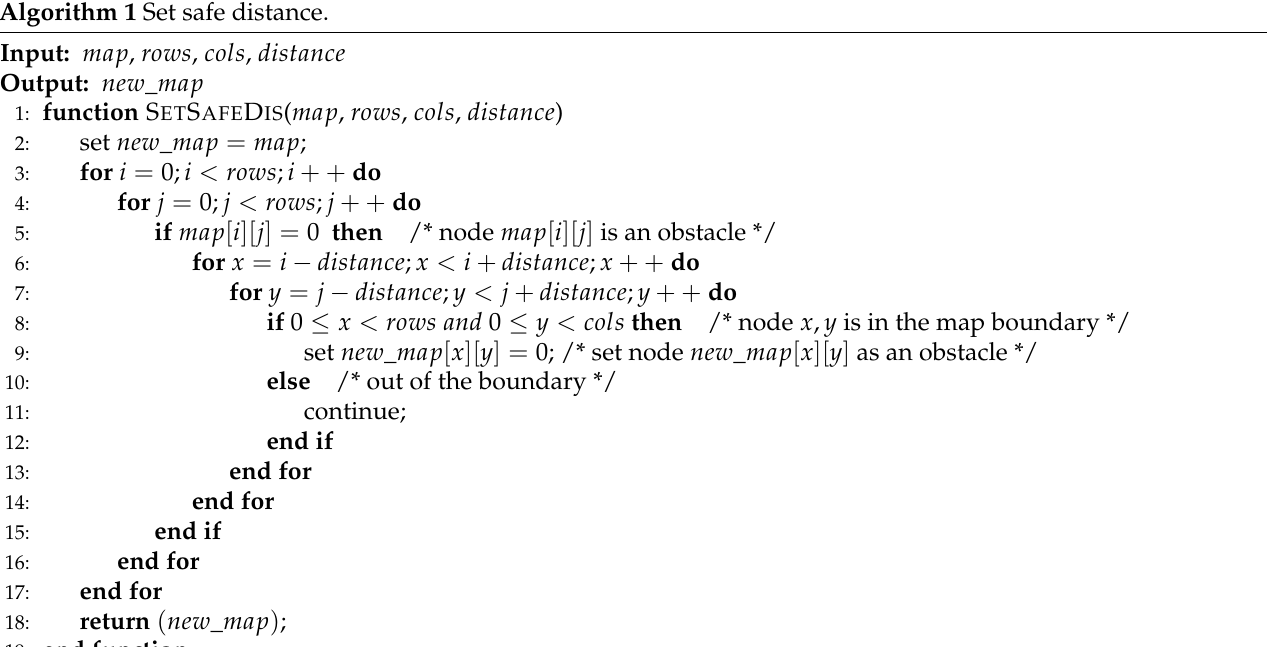
Algorithm 1 Set safe distance.